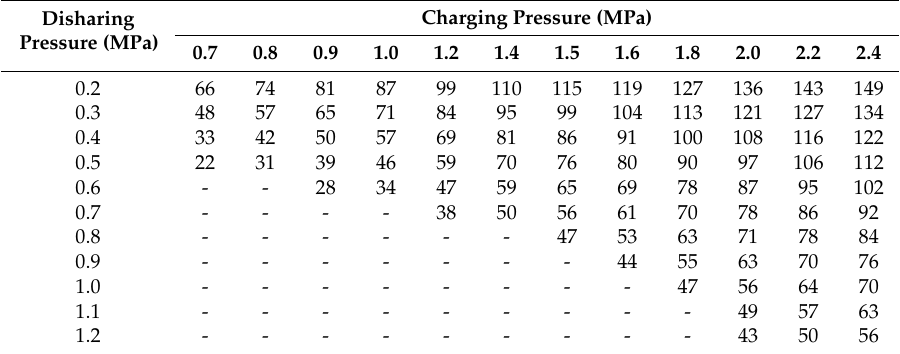
Table 1. Specific thermal energy storage capacities (STESCs) under different charging and discharging pressures (in kg/m 3 ).